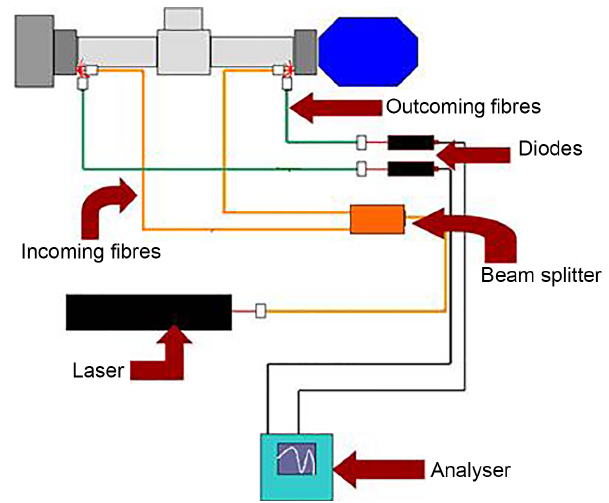
Figure 10. The measurement setup.